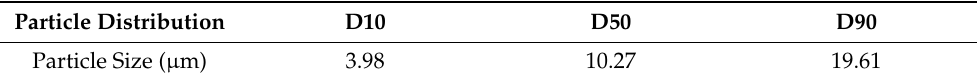
Table 1. Particle size distribution of as-received 316L stainless steel powder. Particle Distribution